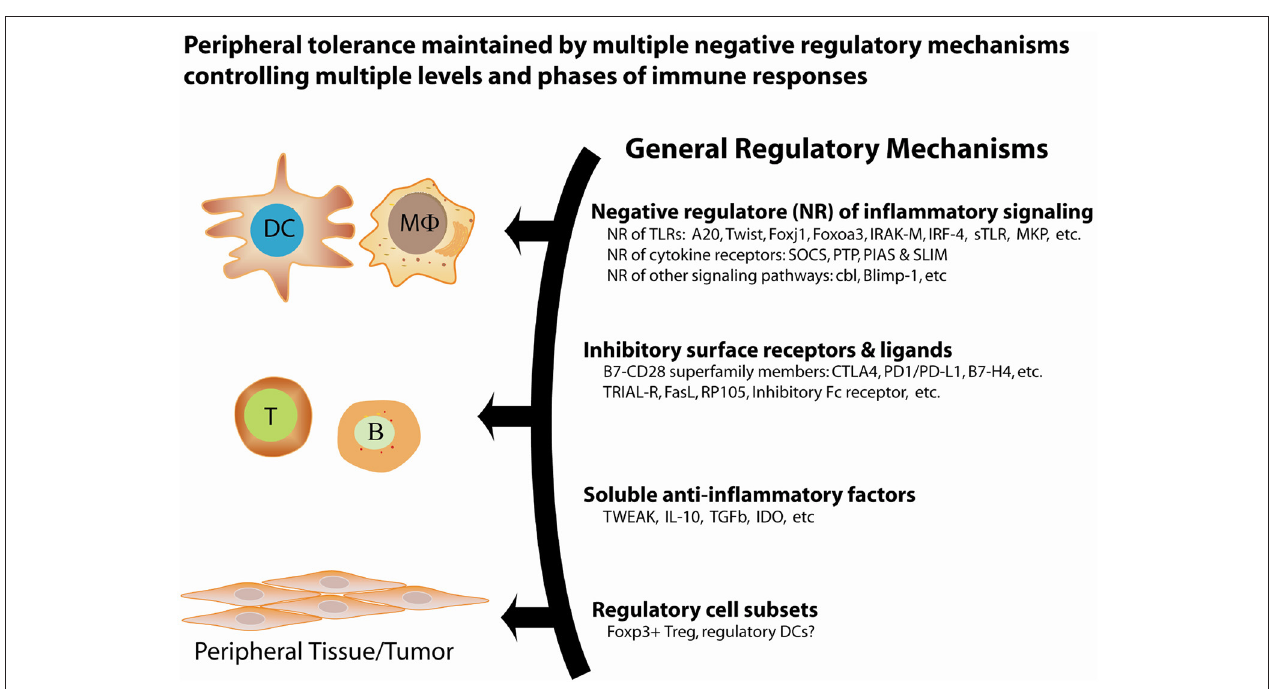
FIGURE 1 | General regulatory mechanisms for the maintenance of peripheral tolerance. Peripheral tolerance is maintained by at least four interrelated, non-redundant regulatory mechanisms that work in concert to negatively regulate multiple levels of immune responses, including antigen presentation, lymphocyte activation and effector function, and peripheral